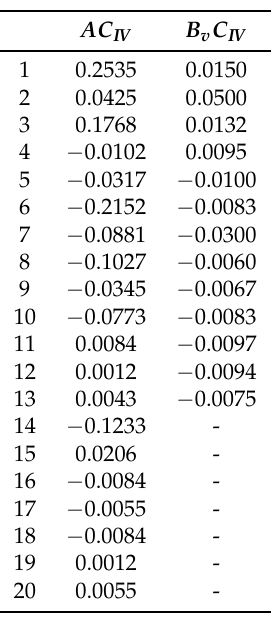
Table 5. Constant vectors A C IV and B v C IV in a 14 buses system.